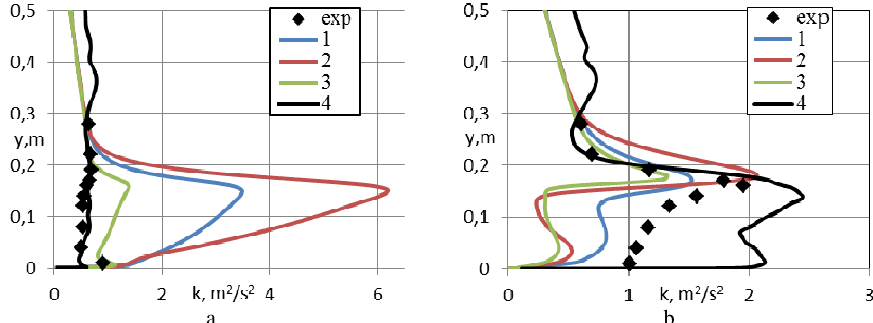
Fig. 5. Profiles of the turbulence kinetic energy (k) in the sections (a) X1 and (b) X2 obtained from experimental data and in numerical calculations with the various turbulence